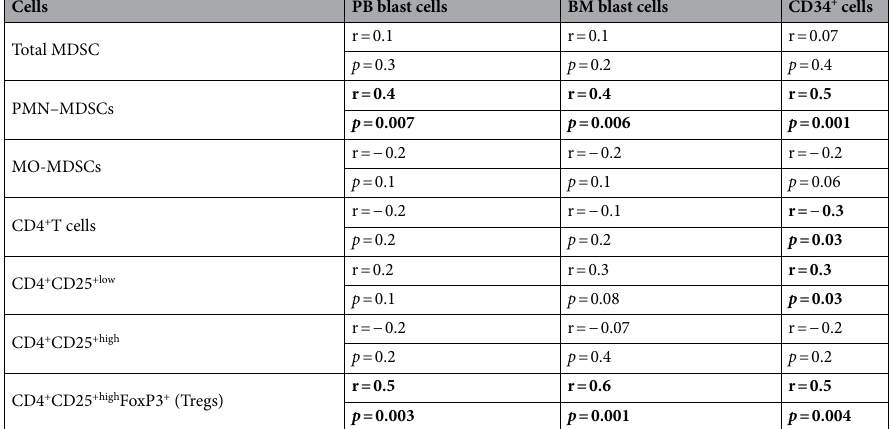
Table 3. Relations of peripheral myeloid-derived suppressor cells and regulatory T cells with blast cells in children with B-cell acute lymphoblastic leukemia. PB peripheral blood, BM bone marrow, MDSCs myeloid- derived suppressor cells, PMN—MDSCs : polymorphonuclear myeloid-derived suppressor cells, MO-MDSCs monocytic myeloid-derived suppressor cells, Tregs regulatory T cells. Pearson correlation, r Pearson’s correlation coefficient, significant p- value <